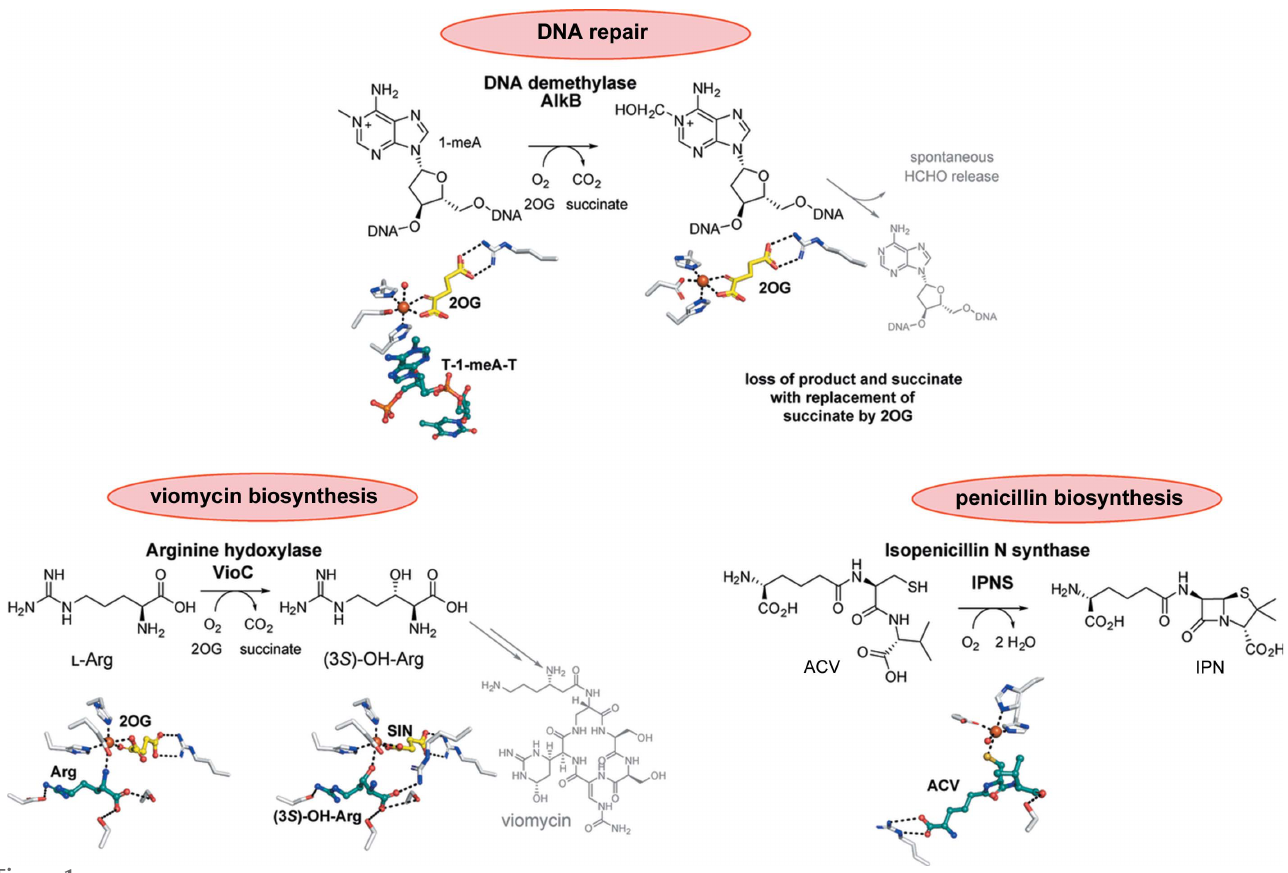
Figure 1 Summary of the reactions catalysed by the enzymes used in this study, i.e. the two 2OG-dependent oxygenases AlkB and VioC, and IPNS. The presence of a substrate in the active site is a clear indication of whether or not molecular dioxygen has diffused to the active site and reacted productively. The figure was constructed using the following structures: VioC:Fe:2OG:Arg (PDB entry 6y0n), VioC:Fe:SIN:(3 S )-OH-Arg (PDB entry 6y12), AlkB:Fe:2OG:T-1-meA-T (PDB entry 6y0q), AlkB:Fe:2OG (PDB entry 6ypv) and IPNS:Fe:ACV (PDB entry 6y0o). SIN =